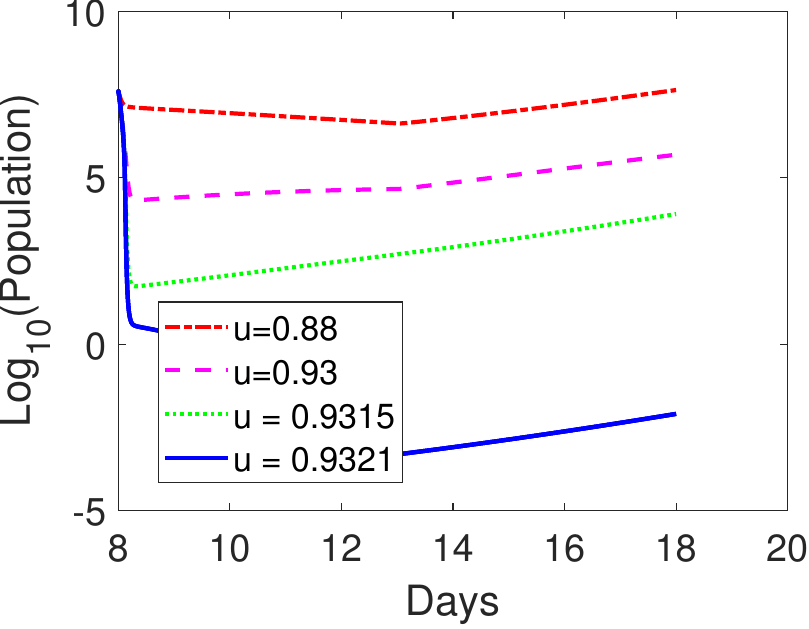
Figure 4. Comparison among numerically simulated dynamics of susceptible tumor cells for OV- aCTLA-4 treatment with various blockade rates of CTLA-4 on day 18 post-implementation. The initial condition is as in Figure 2. The various blockade rate of CTLA-4 is represented by u as in the figure. The therapy is administered on day 8 and holds for 5 days. The same dosages of oncolytic virus as in Figure 2, s = 2 × 10 6 , is applied to OV-aCTLA-4 treatment. Other parameter values are given in Table